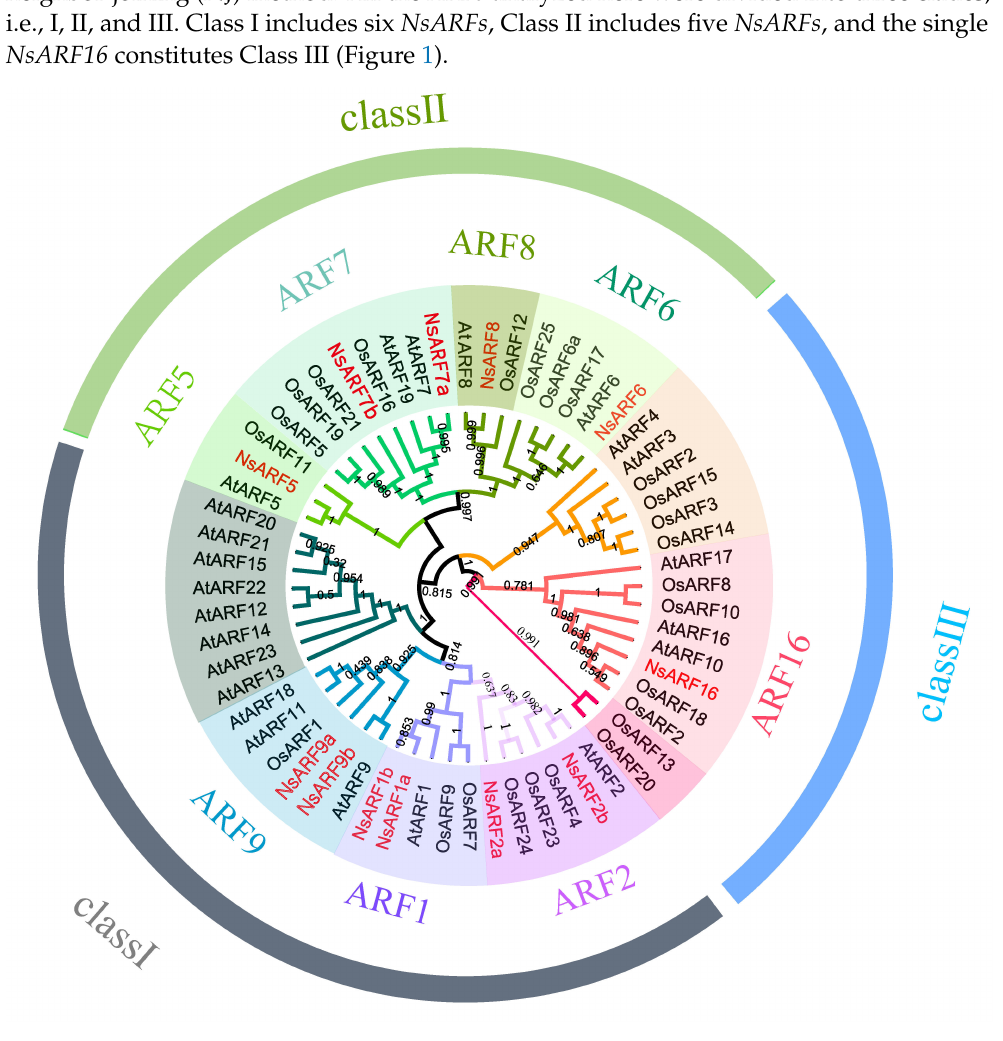
Figure 1. Phylogenetic relationships of the ARF family genes from Nitraria sibirica ( Arabidopsis thaliana ,